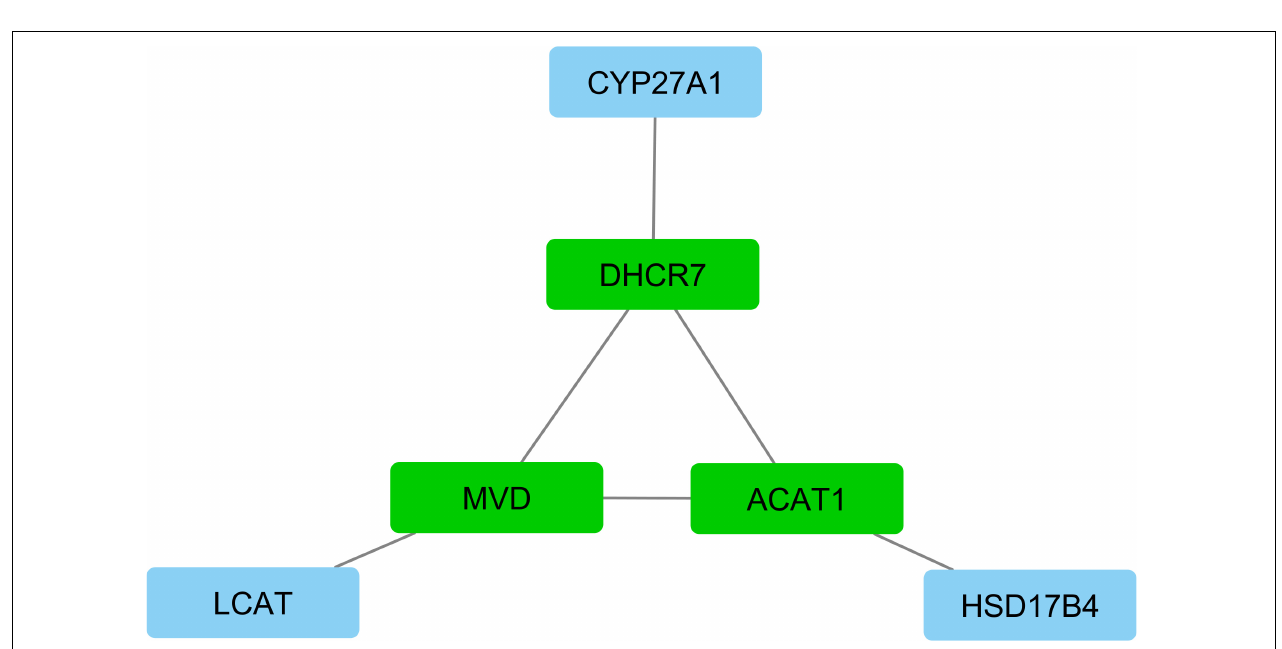
FIGURE 6 | Module 3: six genes in interactive bipartite network of gene–miRNA. In this network, the quadrilateral nodes represent genes; and edges indicate the gene–gene interaction effects. Green quadrilateral nodes represent the hub genes in the network. Blue nodes represent other genes in the network.